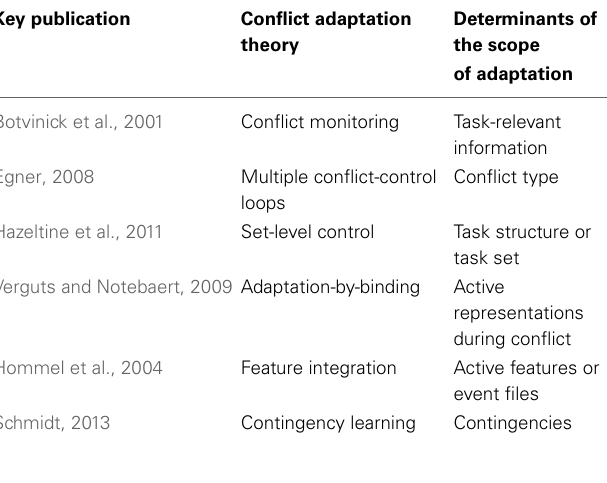
Table 1 | Brief description of theories and their view on the scope of conflict